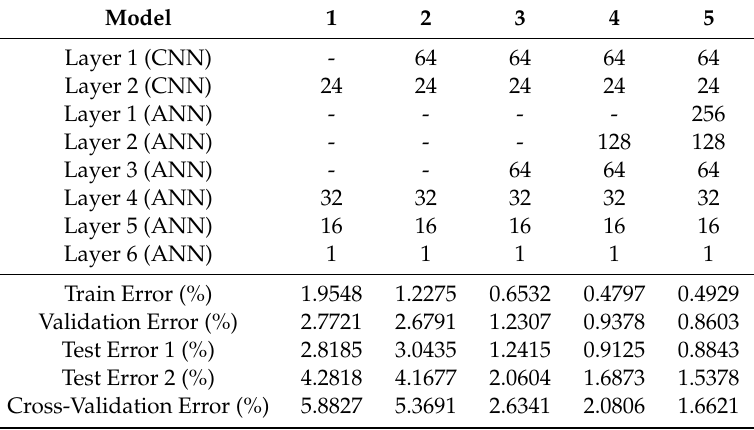
Table 1. Summary of the results of the di ff erent structures. ANN: artificial neural network; CNN: convolutional neural